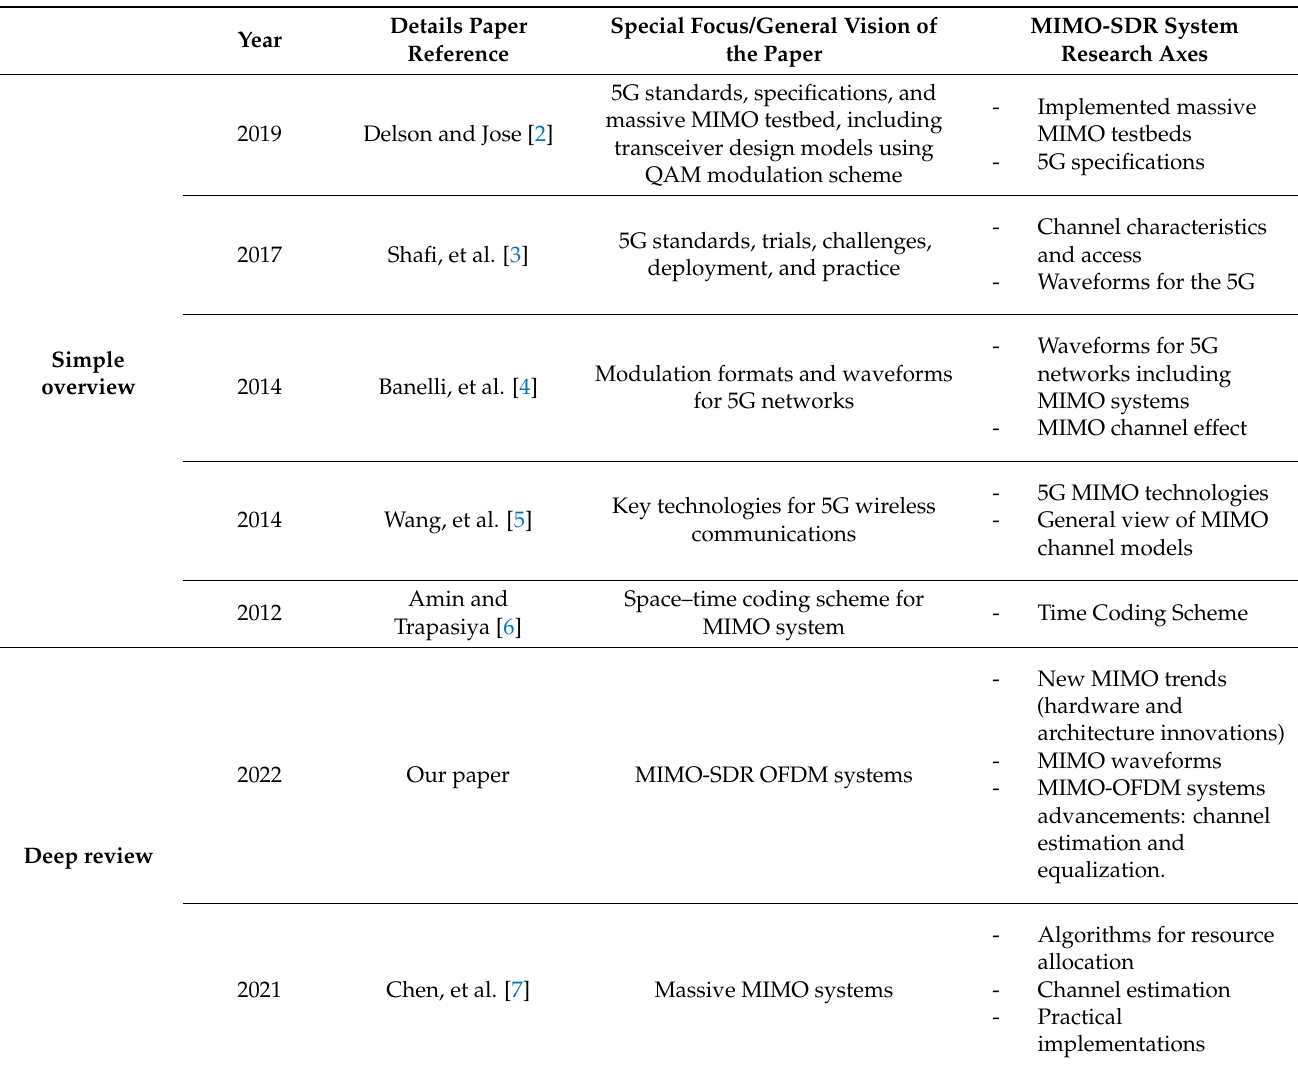
Table 1. Review paper concerning MIMO-SDR